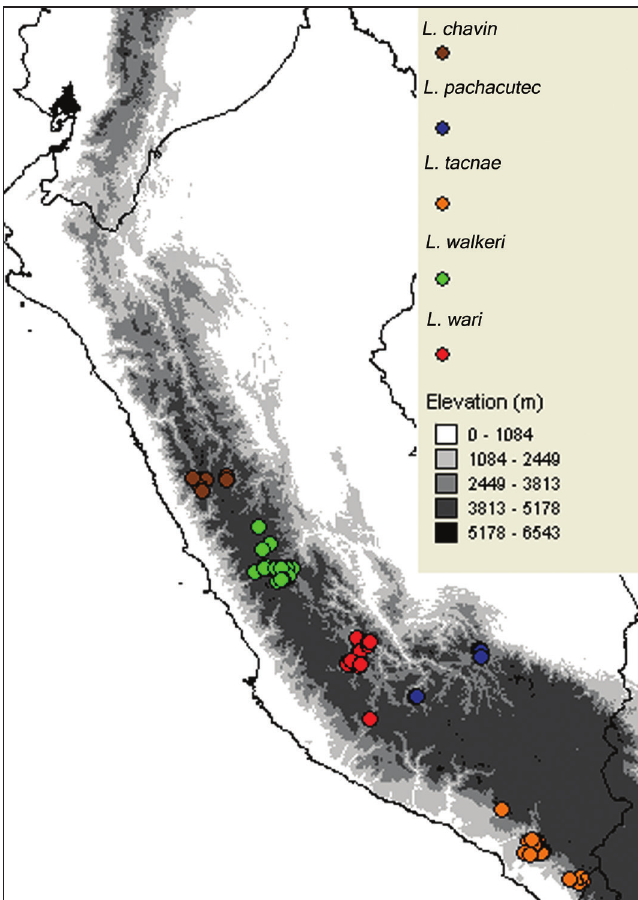
Figure 11. Geographic distribution of L. chavin, L. pachacutec, L. tacnae, L. walkeri, and L. on throat, femur, tibia, posterior third of belly and laterally in anterior two thirds of belly. Small and scattered dark marks in chest and anterior two thirds of belly. Tail with dark horizontal rows. Color pattern in life. Head dorsally brown with black dots. Subocular cream. A black vertebral band with a thin yellow stripe on the middle. The vertebral band has a thin white stripe on each side. Paravertebral field with dark marks with posterior white dots. Creamy-yellow dorsolateral stripes. Lateral field with black marks sepa- rated by cream diagonal stripes. Yellowhish-white ventrolateral stripe, beginning on upper margin of eye, continuing from auricular meatus, the longitudinal neck fold, through the shoulders, ending in the groin. Ventrolateral similar to lateral field and same color as the paravertebral field, with diffuse dorsal markings. Forelimbs, chest and belly yellowish-white with scattered and diffuse black dots. Black marks on hind